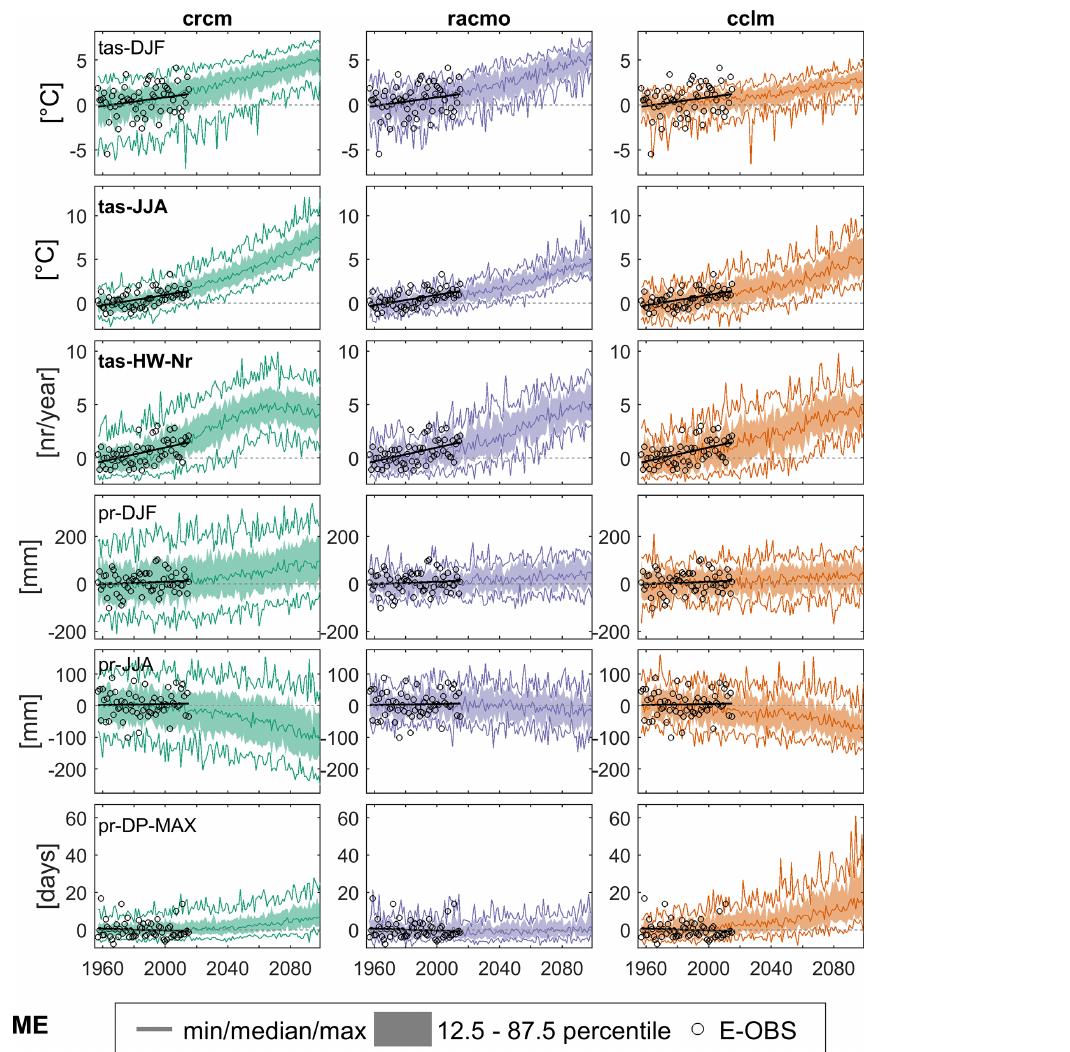
Figure 4. Anomalies from 1961 to 1990 of the six indicators in mid-Europe (ME) for E-OBS (circles 1957–2015) and the three ensembles (1957–2099), represented by the median, minimum and maximum (solid lines) of the ensemble and an area from the 12.5th and 87.5th percentile, spanning the range of the inner 75% of the members (shading). Black lines show the linear trend for the E-OBS points. The indicator names are in bold when the trend is significant using a Mann–Kendall test ( α = 0 .